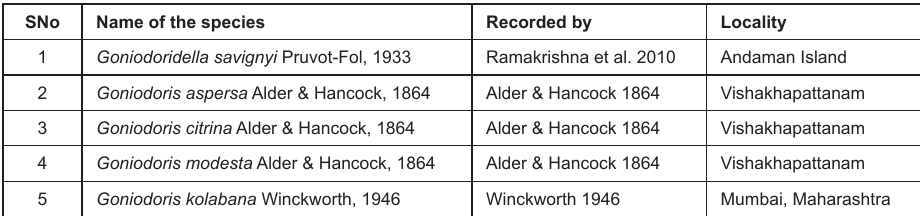
Table 1. Goniodorid fauna recorded from India